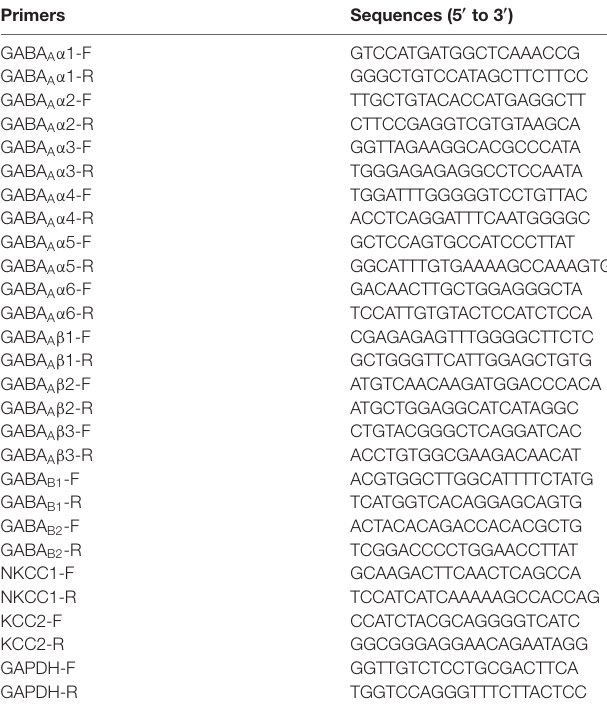
TABLE 1 | The primer sequences used in